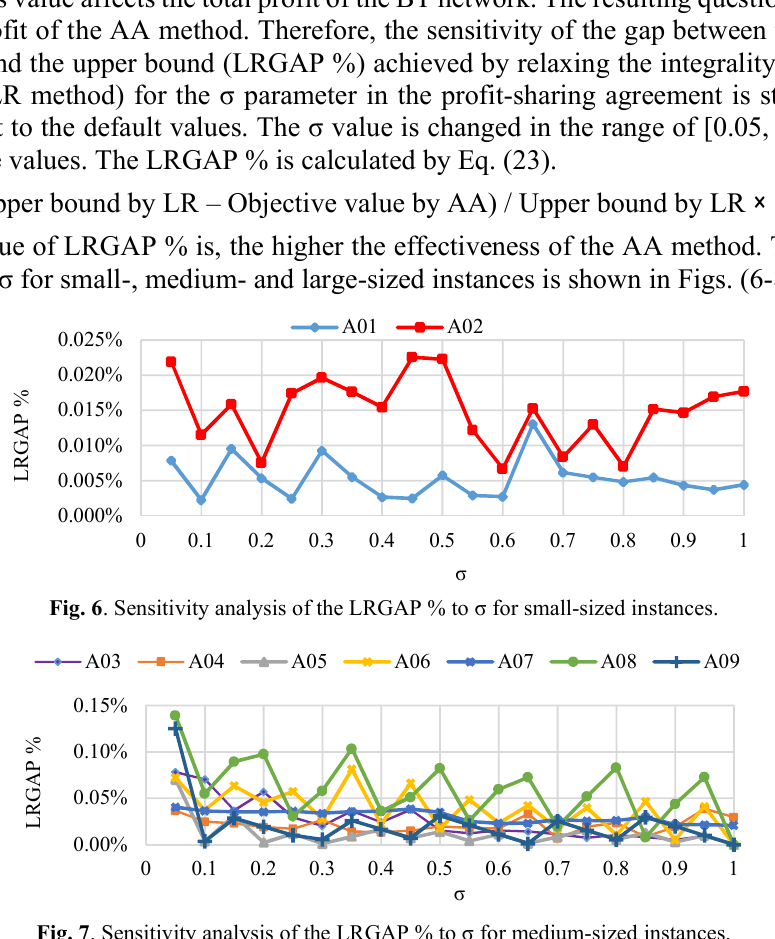
Fig. 7 . Sensitivity analysis of the LRGAP % to σ for medium-sized instances.